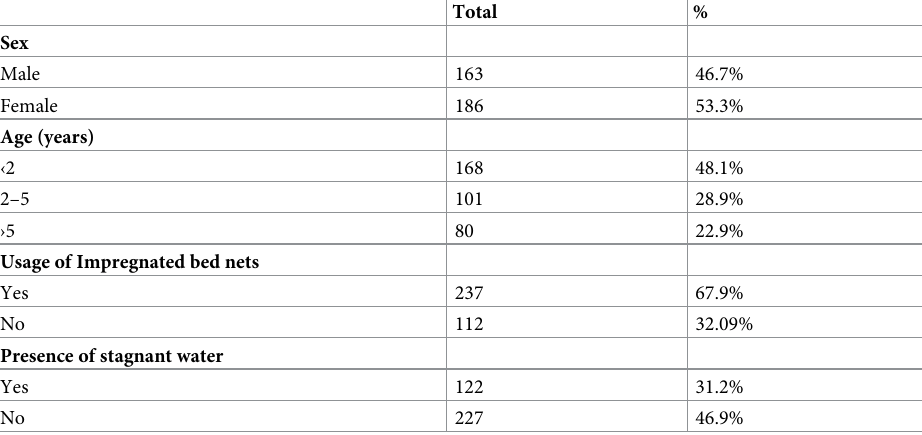
Table 1. Description of the study